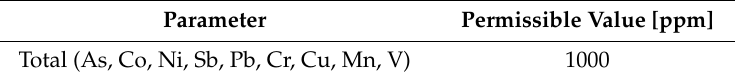
Table 2. Permissible values of the share of heavy metals in the molded fuel. Parameter Permissible Value